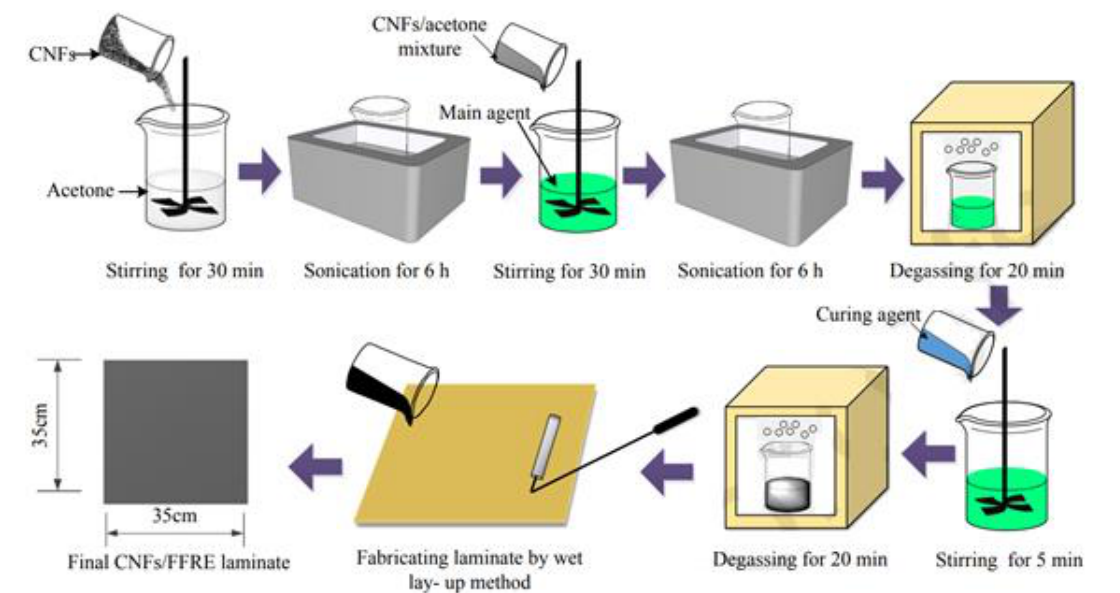
Figure 2. Fabrication of flax carbon nanofibers polymer composite (Adapted from the reference [42]).